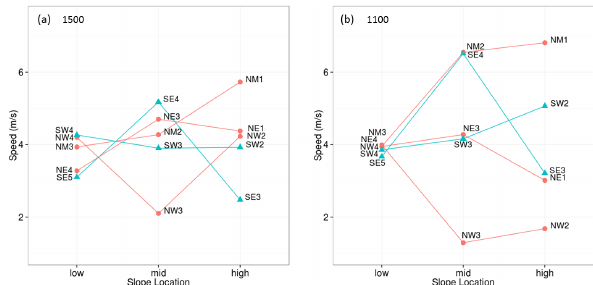
Figure 18. Average wind speeds for sensors at three slope loca- tions (low, mid, and high) along five transects during the (a) synop- tically driven upvalley and (b) synoptically driven downvalley flow regimes at the Salmon River Canyon site. Blue and red lines are transects on the southern and northern sides of the river, respec-